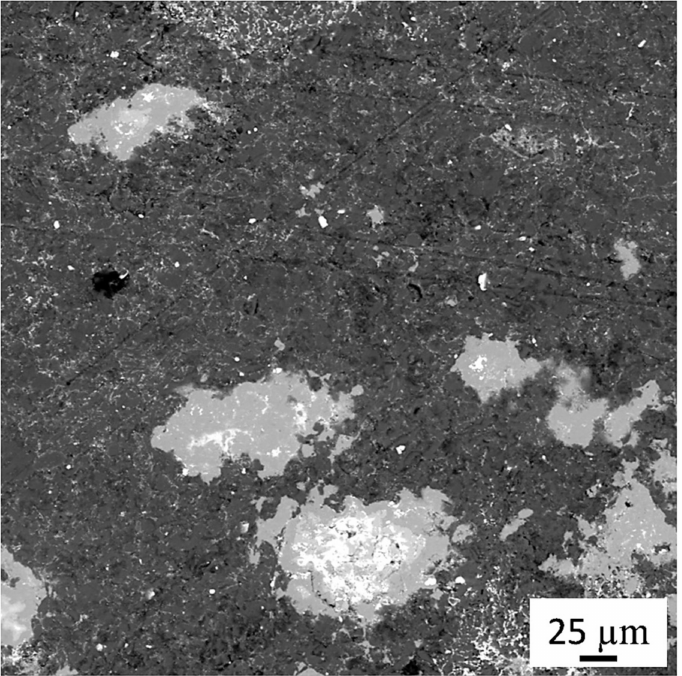
Figure 2. SEM image of the Al–Mo alloy.